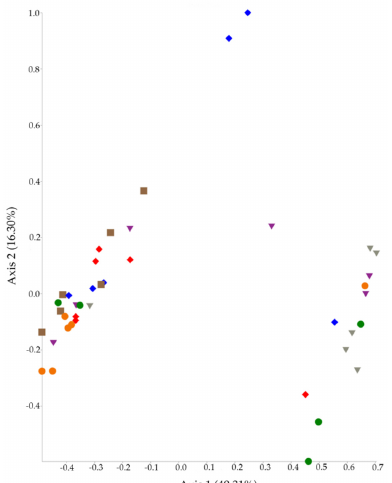
Figure 1. PCoA plot of beta diversity analysis of caecal samples. Amoxicillin group (AMX) (red), amoxicillin + diclazuril group (AMX + DCZ) (blue), thiamphenicol group (THP) (purple), thiam-